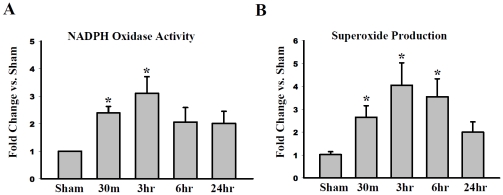
Temporal Expression of NADPH Oxidase Activity and Superoxide Production in the Hippocampal CA1 Region Following GCI.Homogenates taken from the hippocampus CA1 at 30 min, 3 h, 6 h, 24 h after reperfusion were subjected to NADPH oxidase activity (A) and superoxide production (B) assays to assess temporal expression following ischemia-reperfusion. Data is expressed as optical density (OD) and represented as fold vs. sham from four to five animals. *
p<0.05 vs. sham control.